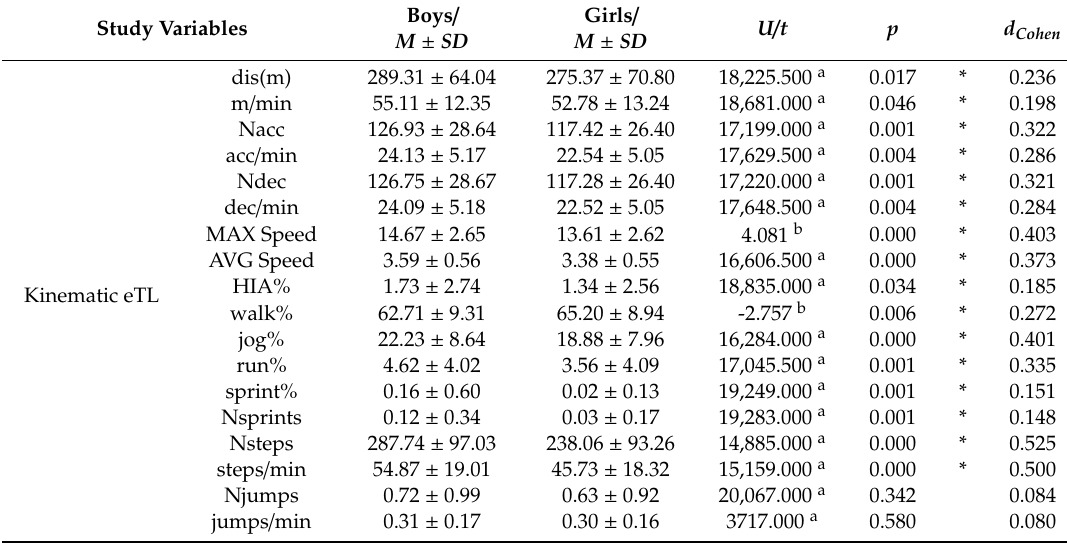
Table 3. Results of the assessment tests according to